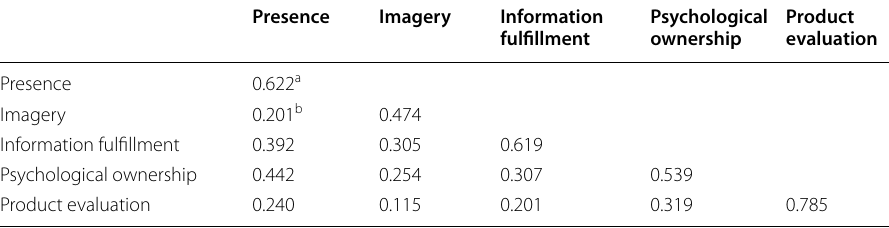
a AVE of constructs is displayed diagonally b Numbers below the diagonal are squared correlation estimates of two